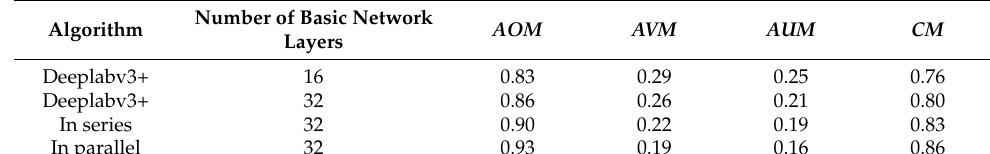
Table 8. Cloud sheltered coastline extraction effect.